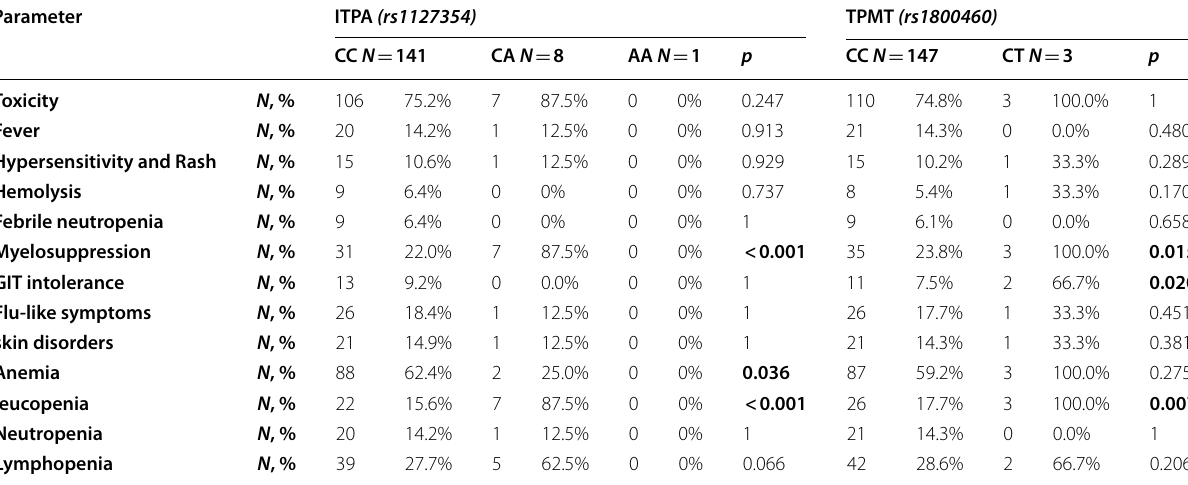
OR odds ratio; CI confidence interval; GIT Gastrointestinal tract Bold values indicate significant results <